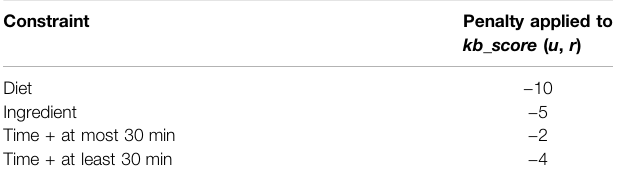
TABLE 4 | Penalties applied to kb _ score ( u , r ) depending on the constraint relieved. Constraint Penalty applied to